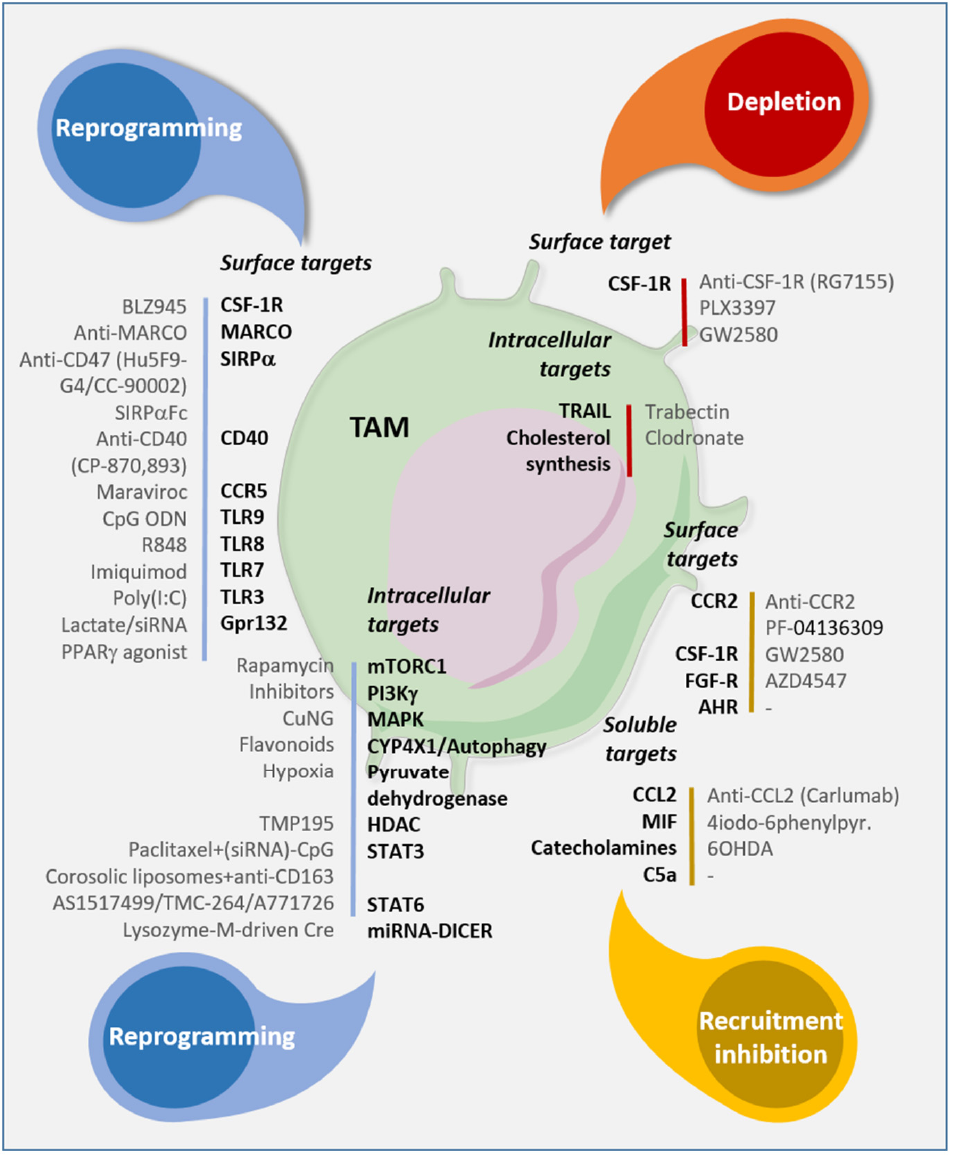
Figure 6. Targeting strategies to reprogram, eliminate, and inhibit TAM recruitment. Antibodies or molecules available to target surface, intracellular or soluble molecules involved in the phenotype, functions, and recruitment in the TME. From Laplagne et al. [61].